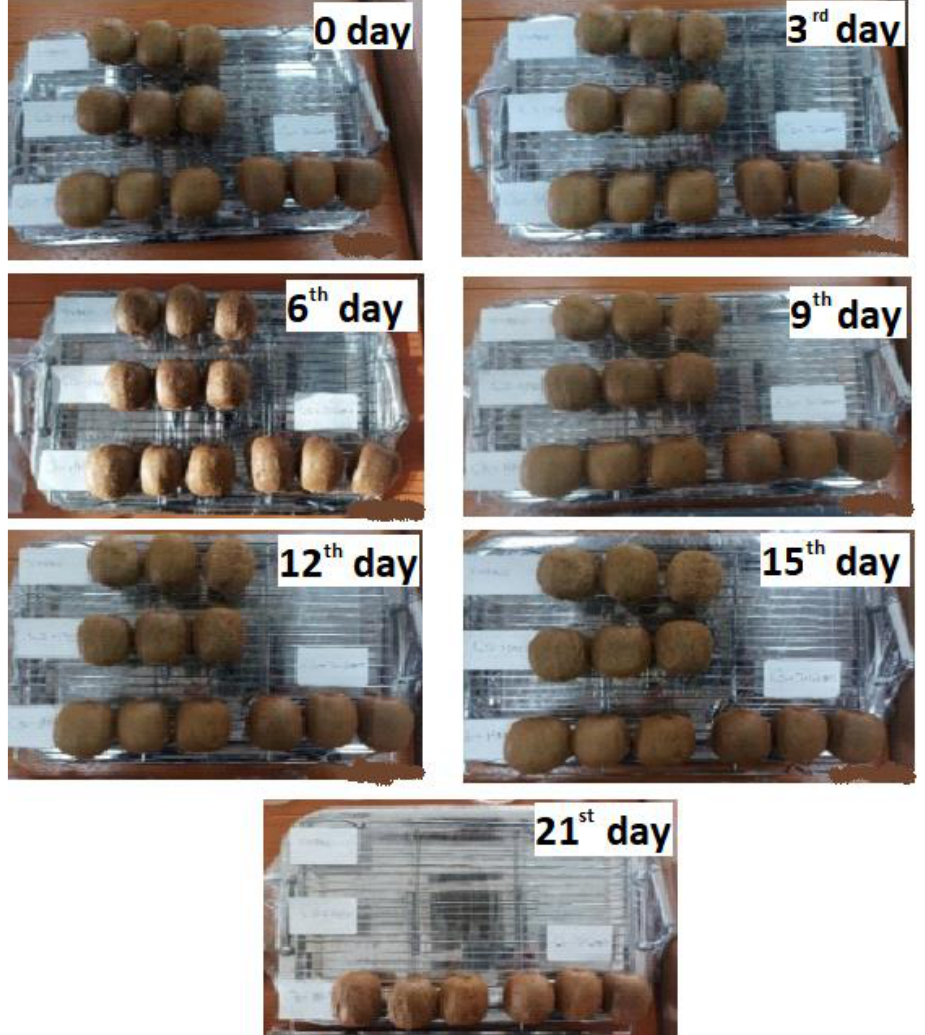
Figure 11. Images of uncoated kiwifruits, coated with CS/PVOH solution kiwifruits, coated with CS/PVOH/10HNT solution kiwifruits and coated with CS/PVOH/10TO@HNT solution kiwifruits stored at 25 °C and ambient humidity at zero, 3rd, 6th, 9th, 12th, 15th and 21st day.